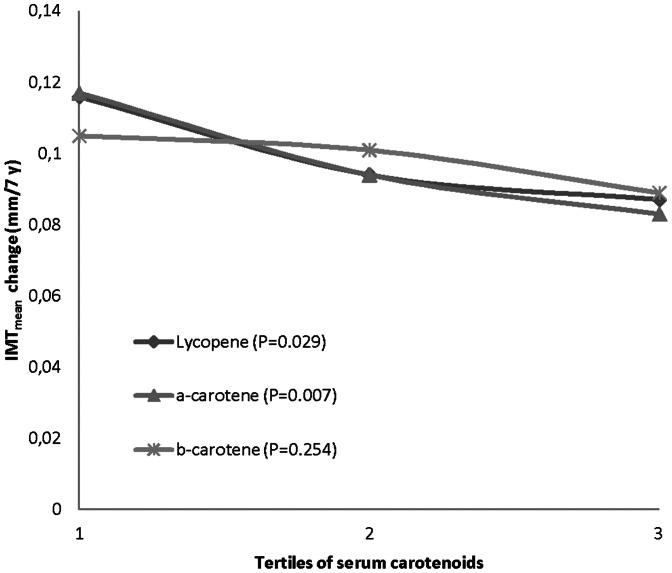
Serum carotenoid tertiles by 7-year IMTmean change (adjusted for age, examination year, ultrasound sonographer, BMI, SBP, IMTmean, smoking, serum LDL cholesterol, physical activity, CHD in family, antihypertensive medication and serum hs-CRP.Probability values are for trend. Carotenoid tertiles (µmol/L): lycopene: ≤0.09, 0.10–0.19, ≥0.20; α-carotene: ≤0.07, 0.08–0.11, ≥0.12; β-carotene: ≤0.26, 0.27–0.41, ≥0.42.